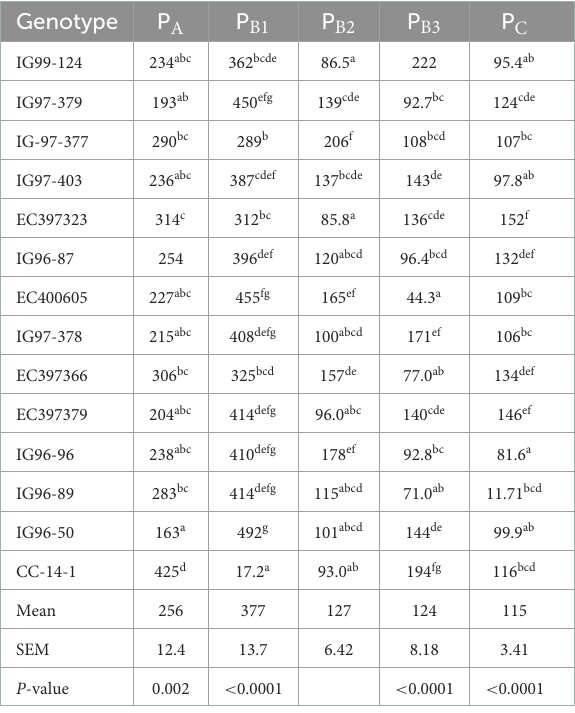
TABLE 4 Protein fractions (g kg − 1 CP) of sugar-rich Cenchrus ciliaris